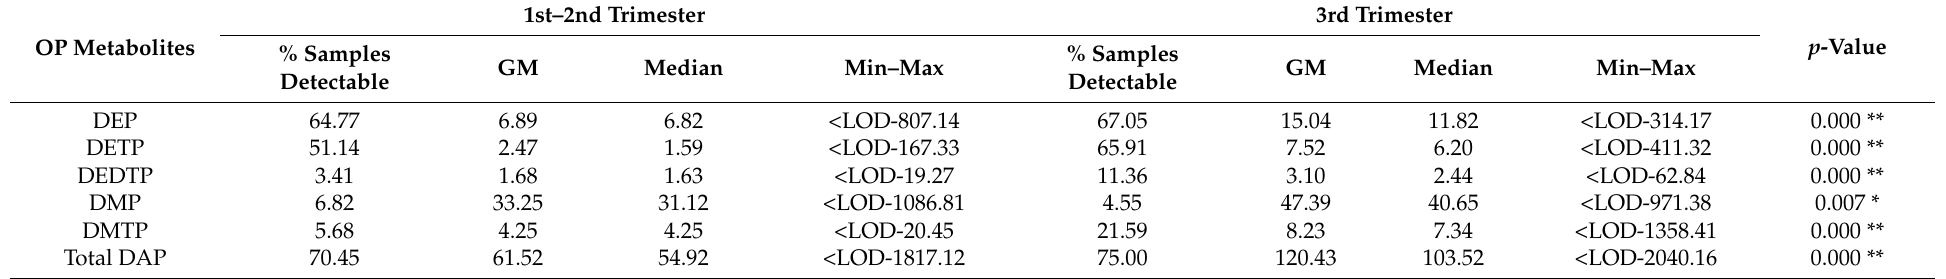
Table 2. Urinary OP metabolites (nmol/g creatinine) in the 1st–2nd trimester and the 3rd trimester of pregnancy in pregnant women ( n = 88) in the agricultural community.